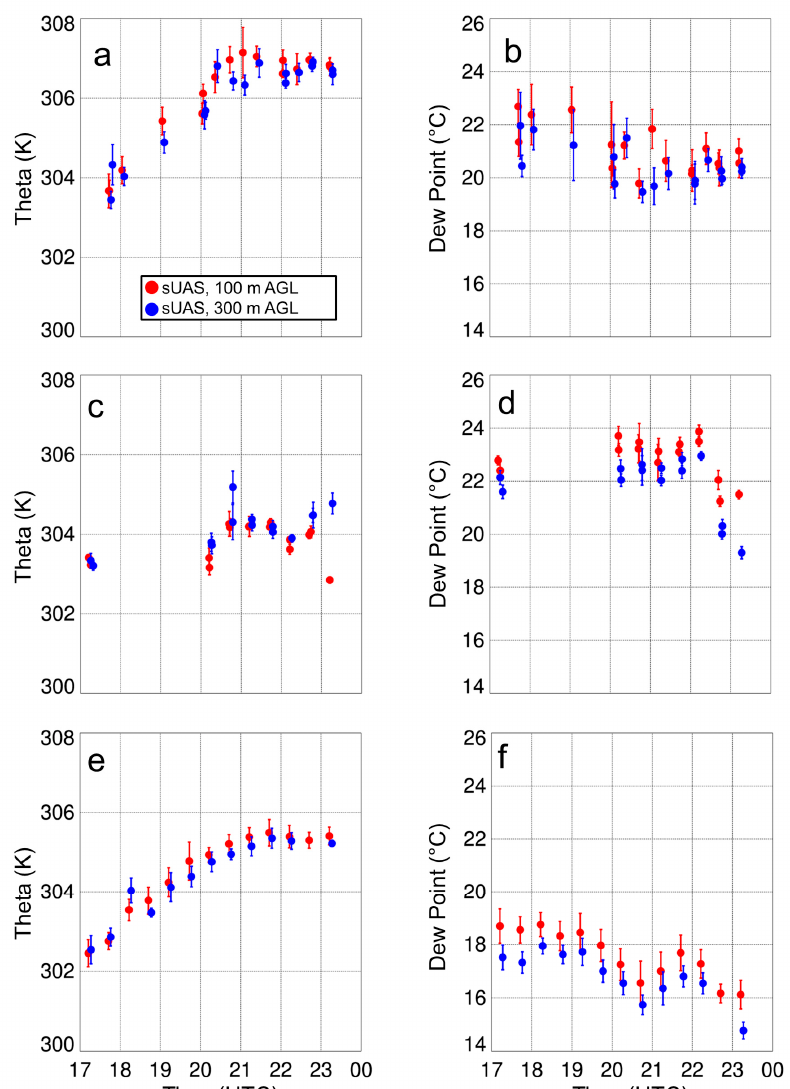
Figure 14. Mean and standard deviation of potential temperature ( a ) and dew point ( b ) during the sUAS flights on 14 August 2017, while the sUAS was flown at 100-m AGL (red) and 300-m AGL (blue). Same for panels ( c ) and ( d ), and for panels ( e ) and ( f ), but for 15 and 17 August 2017,